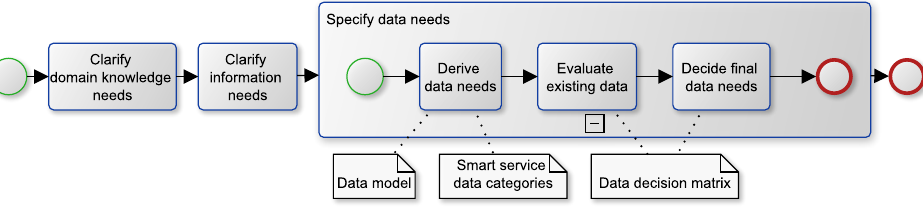
Figure 7. Process steps to specify data